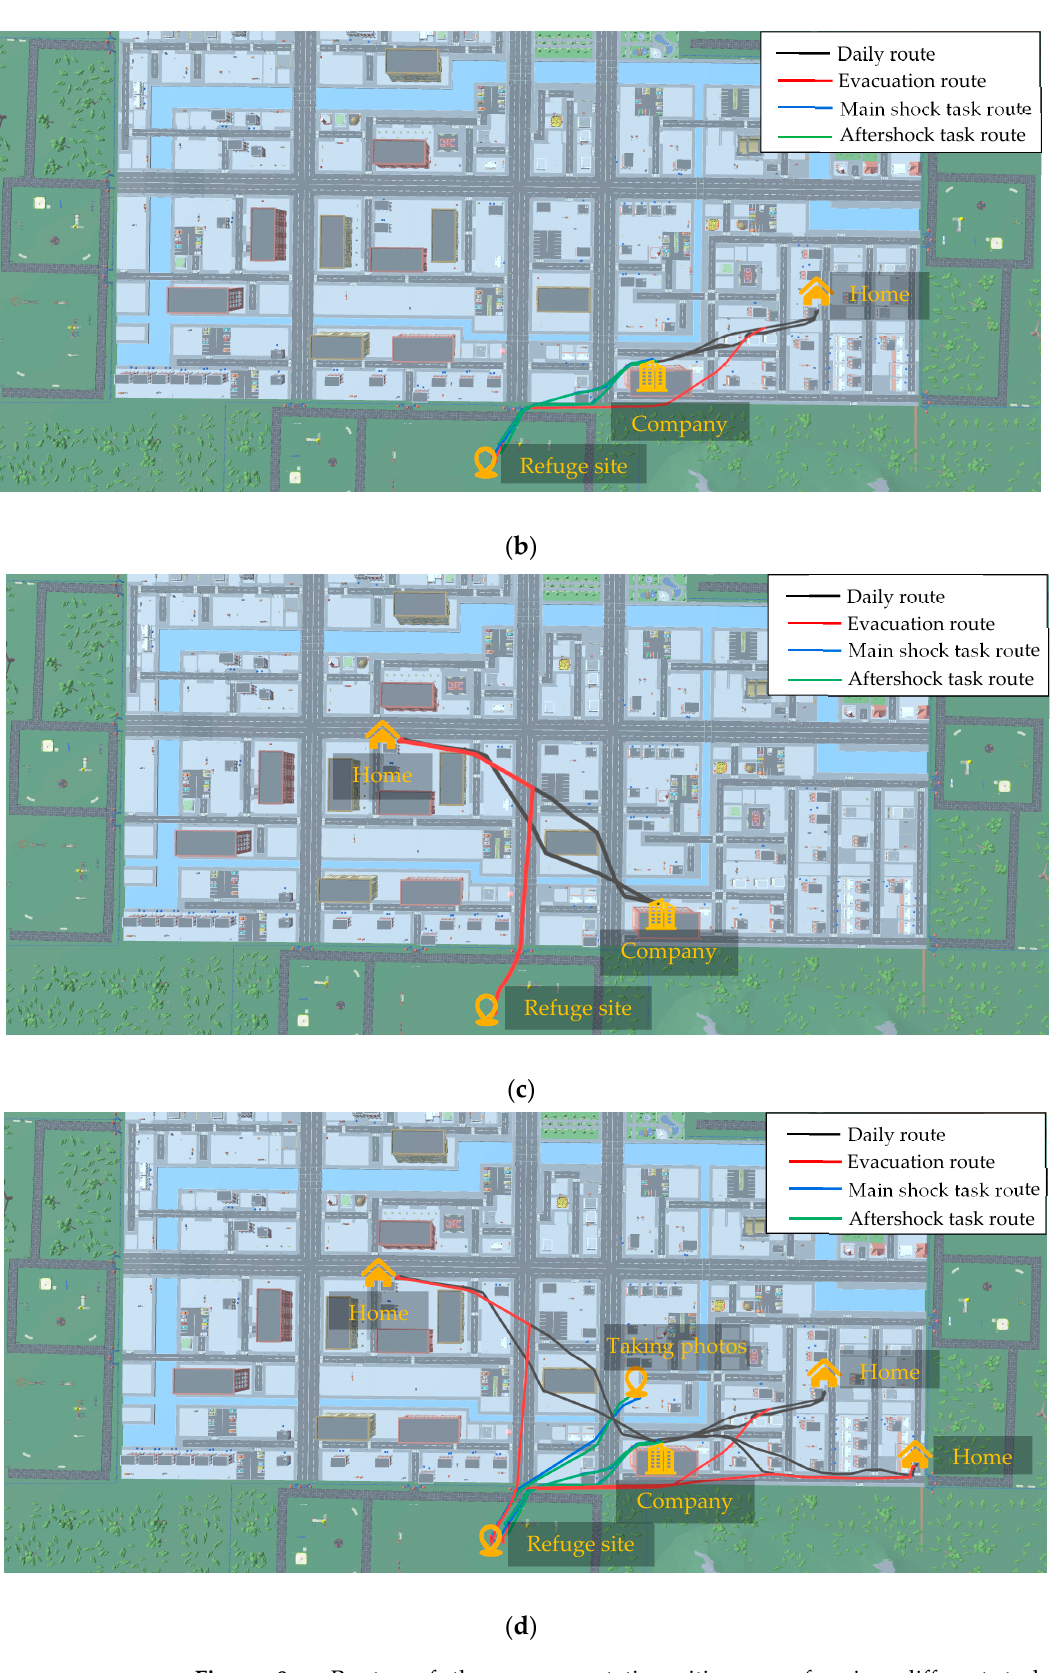
Figure 8. Routes of three representative citizens performing different tasks ( a ) taking photos; ( b ) monitoring; ( c ) without a task; ( d ) all three citizens.